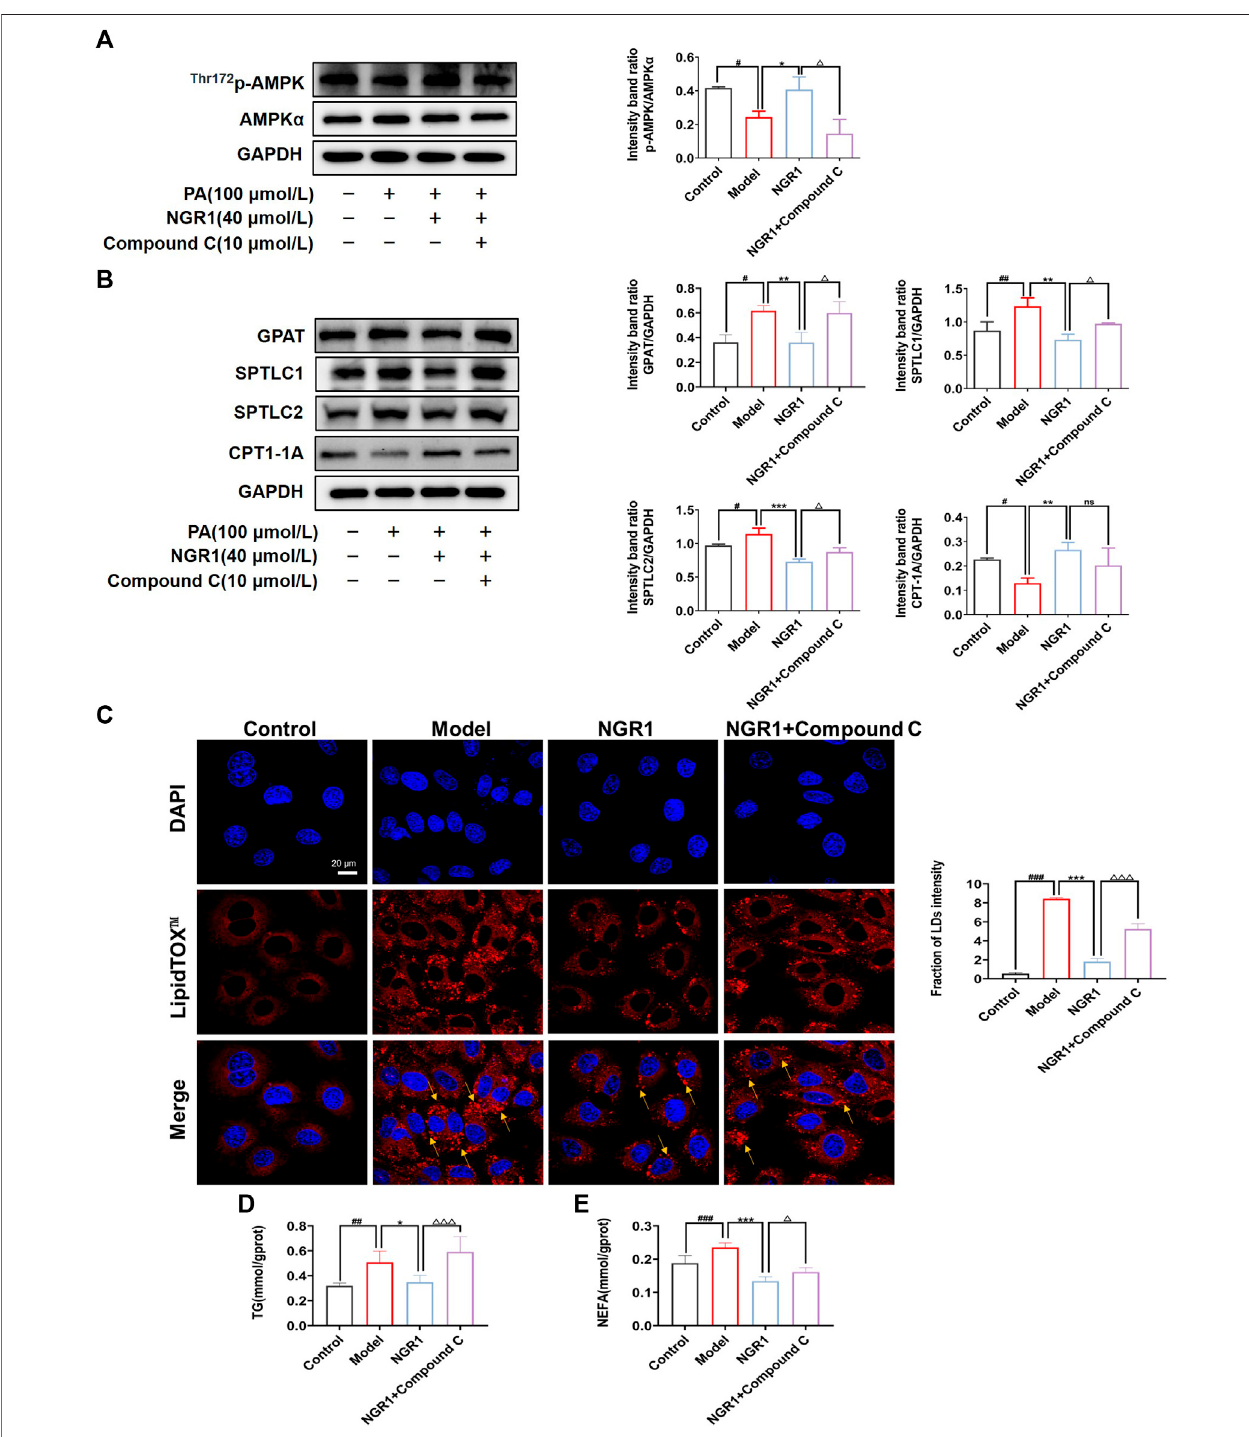
FIGURE 5 | NGR1 reduced cardiac lipotoxicity through AMPK pathway in vitro . (A) NGR1 could increase the expression of p-AMPK in PA-induced model. (B) Western blots analysis of GPAT, SPTLC1, SPTLC2, CPT-1A protein levels in PA-induced H9C2 model treated with NGR1. (C) Representative images of LipidTOX ™ staining in PA-induced H9C2 cells with the treatment of NGR1. Scale bar = 20 μ m. (D) TG assay results showed NGR1 could decrease TG content in cells. (E) NEFA assay results showed NGR1 could decrease NEFA content in PA-induced model. When cells were incubated with Compound C, the effect of NGR1 on cardiac lipotoxicity were aboragated. * p < 0.05, ** p < 0.01, *** p < 0.001 vs. model group, # p < 0.05, ## p < 0.01, ### p < 0.001 vs. control group, △ p < 0.05, △△△ p < 0.001 vs. NGR1 group, ns stands for not statistically signi fi cant. The experiments were repeated three times independently.